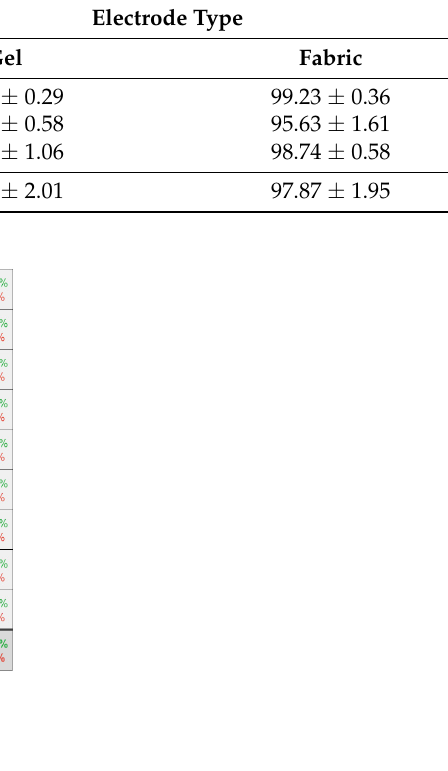
Figure 4. Confusion matrix for 10-fold cross-validation of a model trained on combined gel data from all subjects. The bottom row is the recall, the right column is the precision, and the bottom right is the overall accuracy.